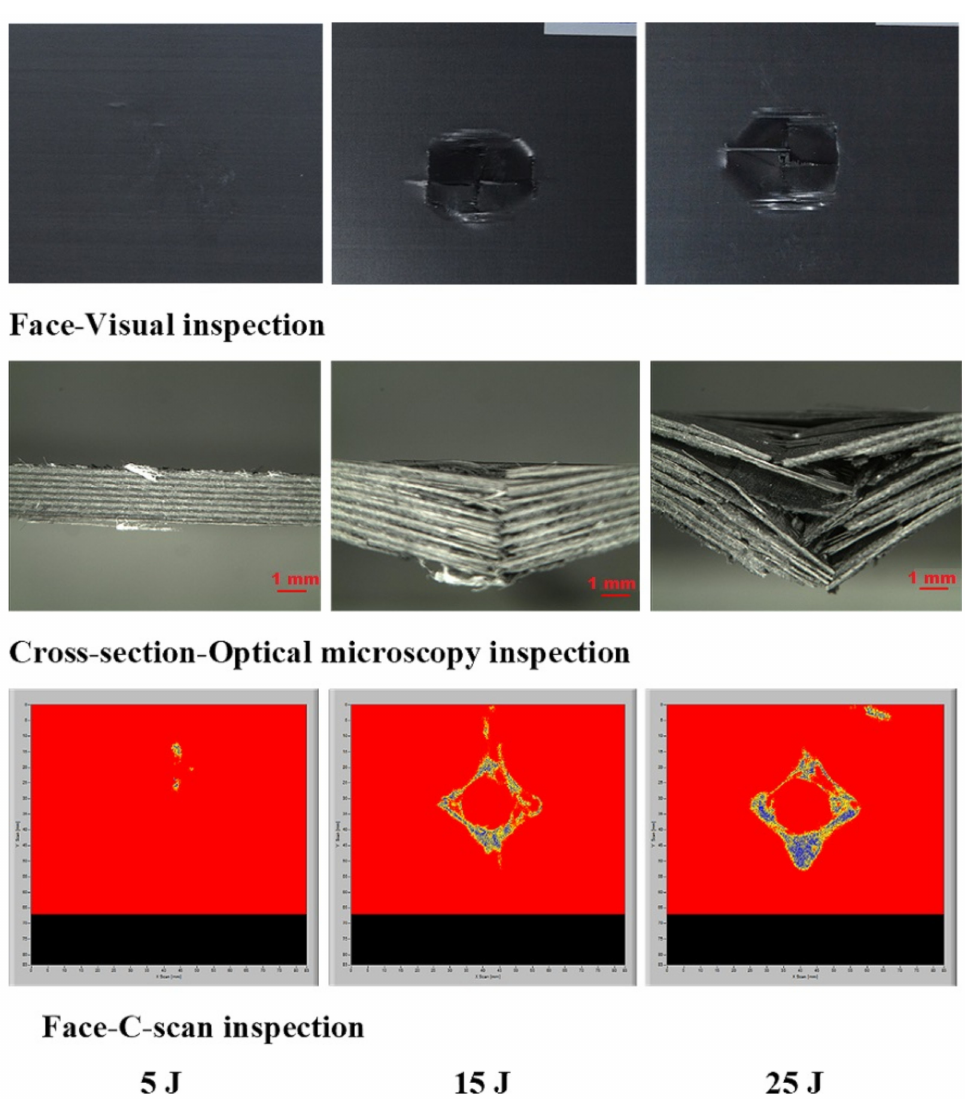
Figure 18. Pictures of the top surface view with C-scan and cross-section with optical microscopy of [B/B] at 5, 15, and 25 J.